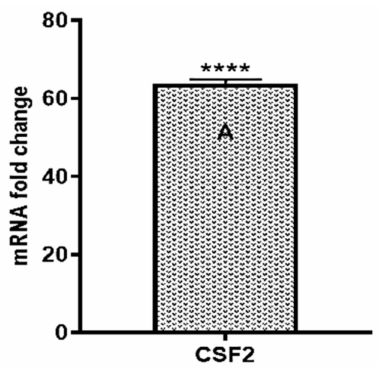
Figure 7. CSF-2 mRNA fold-change following a 24 h co-culture of ST285 with monocytes ( n = 3), compared to control monocytes. The innate and adaptive RT 2 gene profiler arrays were used to determine changes in gene expression. The symbol represents the p -value for Tukey’s test (one-way ANOVA) where **** p <